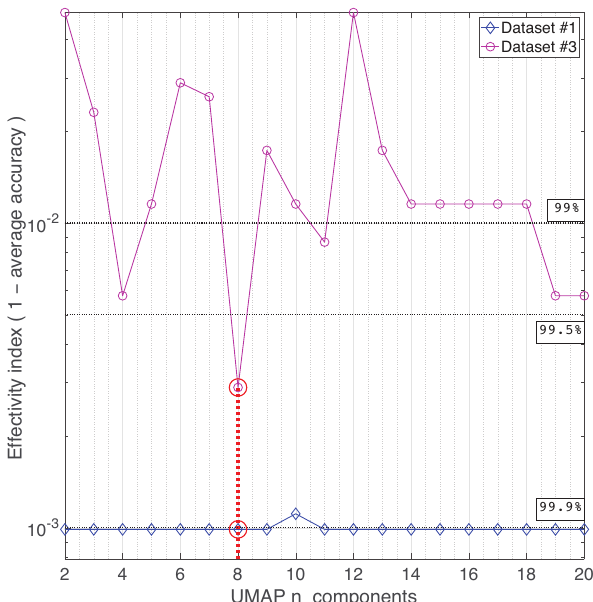
Figure 12. Average accuracy vs. the dimension of the UMAP low-dimensional space d n_components for datasets #1 and #3 (semi-logarithmic plot in the vertical axis). The vertical axis represents the effectivity index. The optimal selected parameters are highlighted in red. The accuracy range for dataset #1 is from 99.888% to 99.901% and that for dataset #3 is from 95.093% to